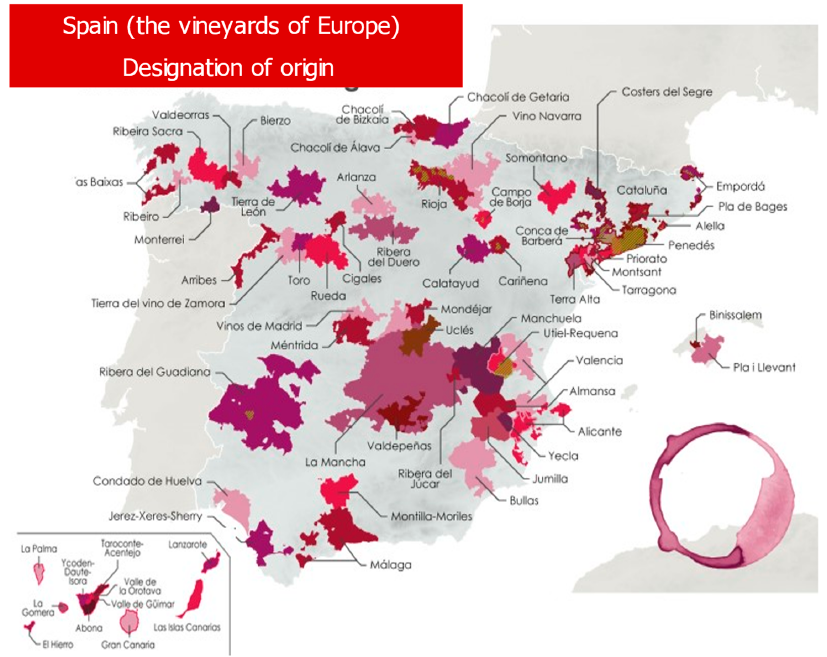
Figure 2. Protected designations of origin for wine in Spain (2021). Source: Ministry of Agriculture, Fisheries and Food (MAPA)